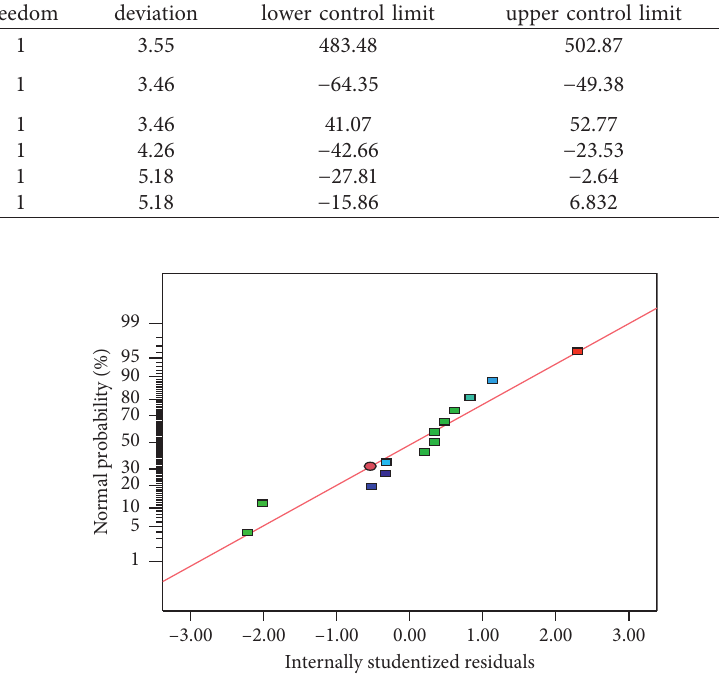
Figure 5: Distribution of the residuals of burnout temperature.